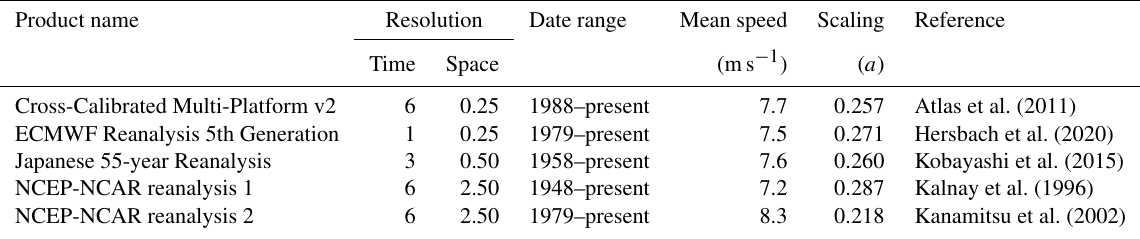
Table A2. Summary of wind products used in this study. Note that the date range starts for the first full year of data. We do not use NCEP1/2 in our main results, but these are included for reference. Time units are in hours and space in degrees. Mean wind speed is given for the ice-free ocean for the three-decade period 1990–2019.